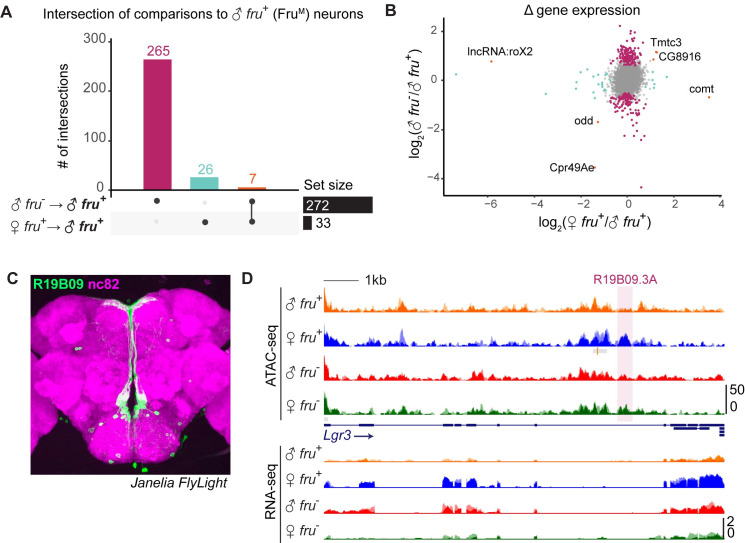
FruM-regulated genes are neither distinct to nor universal across male fruitless neurons.A. UpSet plot showing intersection of differential gene expression (DESeq2 results at FDR <0.05) from male versus female fru+ neurons (33 genes) and male fru+ versus fru- neurons (272 genes). Only 7 genes are differential across both comparisons. B. Distribution of fold change between the binary comparisons shown in (A). Points are colored according to their status in (A). Only 5 genes have differential expression specific to FruM cells (i.e. fold changes in the same direction in both comparisons). C. Adult female brain expression pattern of R19B09 (green) driving expression in aDT6/median bundle neurons with nc82 counterstain (magenta). Image from Janelia FlyLight database. D. UCSC genome browser screenshot of RNA-seq and ATAC-seq signal at Lgr3, a gene that is expressed in female but not male median bundle neurons [25]. Highlighted is R19B09.3A, which Meissner et al. found to be a minimal regulatory element bound by FruMB.